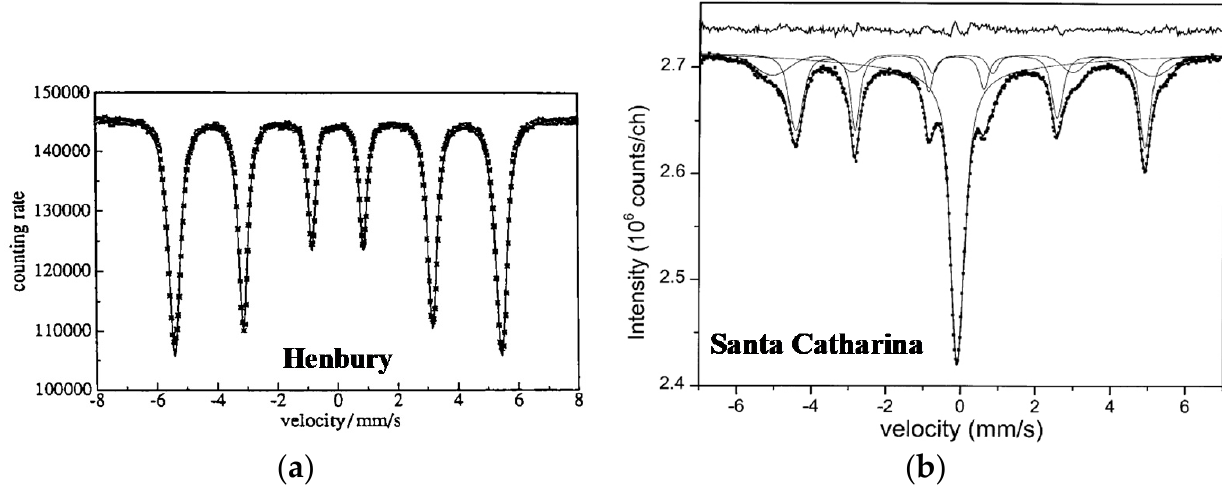
Figure 24. Room temperature Mössbauer spectra of iron meteorite: Henbury IIIAB ( a ) and Santa Catharina IAB-ung; the differential spectrum is shown on the top ( b ). Indicated spectral components are the results of the fits. Adapted from [68,69], respectively.